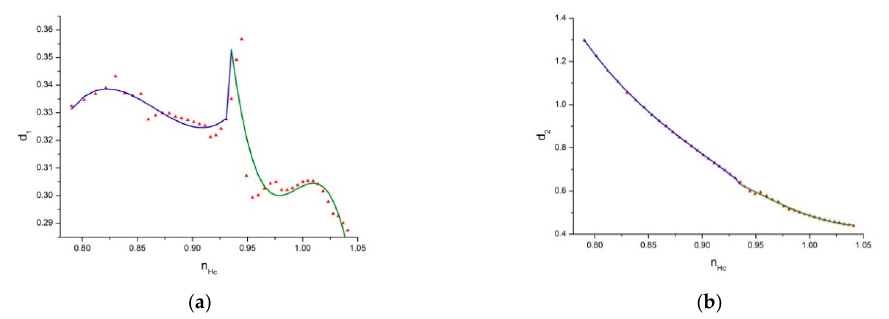
Figure 11. Matrix elements in the system matrix D : ( a ) d 1 ; ( b ) d 2 .